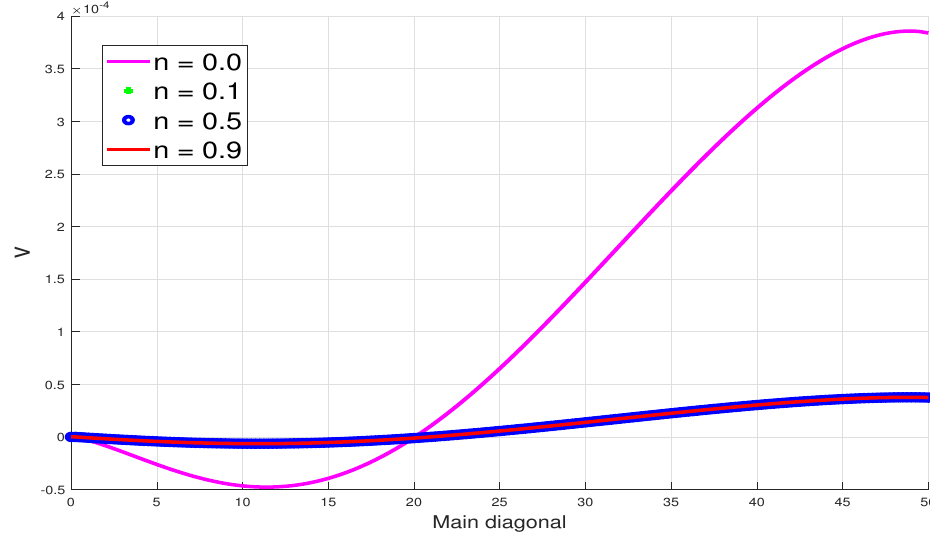
Figure 15. Transverse velocity dependence on n at t = 5.